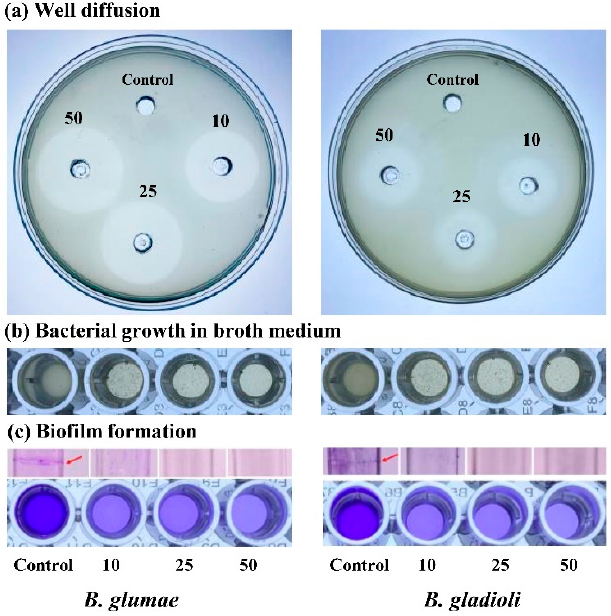
Figure 5. In vitro antibacterial activity of biogenic ZnONPs at three different concentrations (10, 25, and 50 µ g mL − 1 ) against B. glumae and B. gladioli. ( a ) The zone of inhibition was observed by well diffusion assay, ( b ) the inhibition of B. glumae and B. gladioli growth in liquid medium, ( c ) the inhibition of biofilm formation. Table 2. In vitro antibacterial activity of biogenic ZnONPs against rice pathogens against B. glumae and B. gladioli